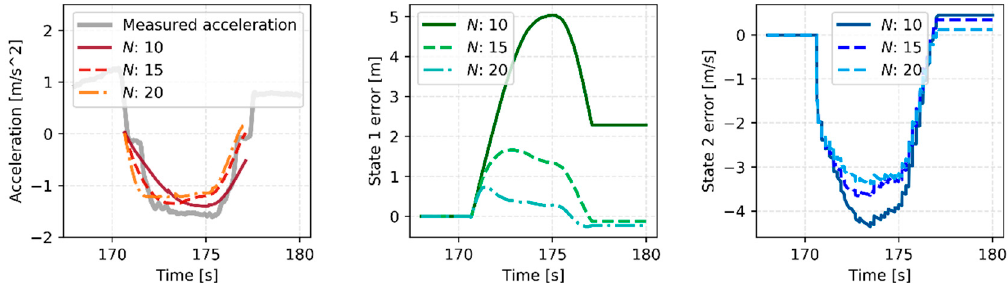
Figure 10. Deceleration planning results according to N weight value ( q df : 0.1, q vf : 4).